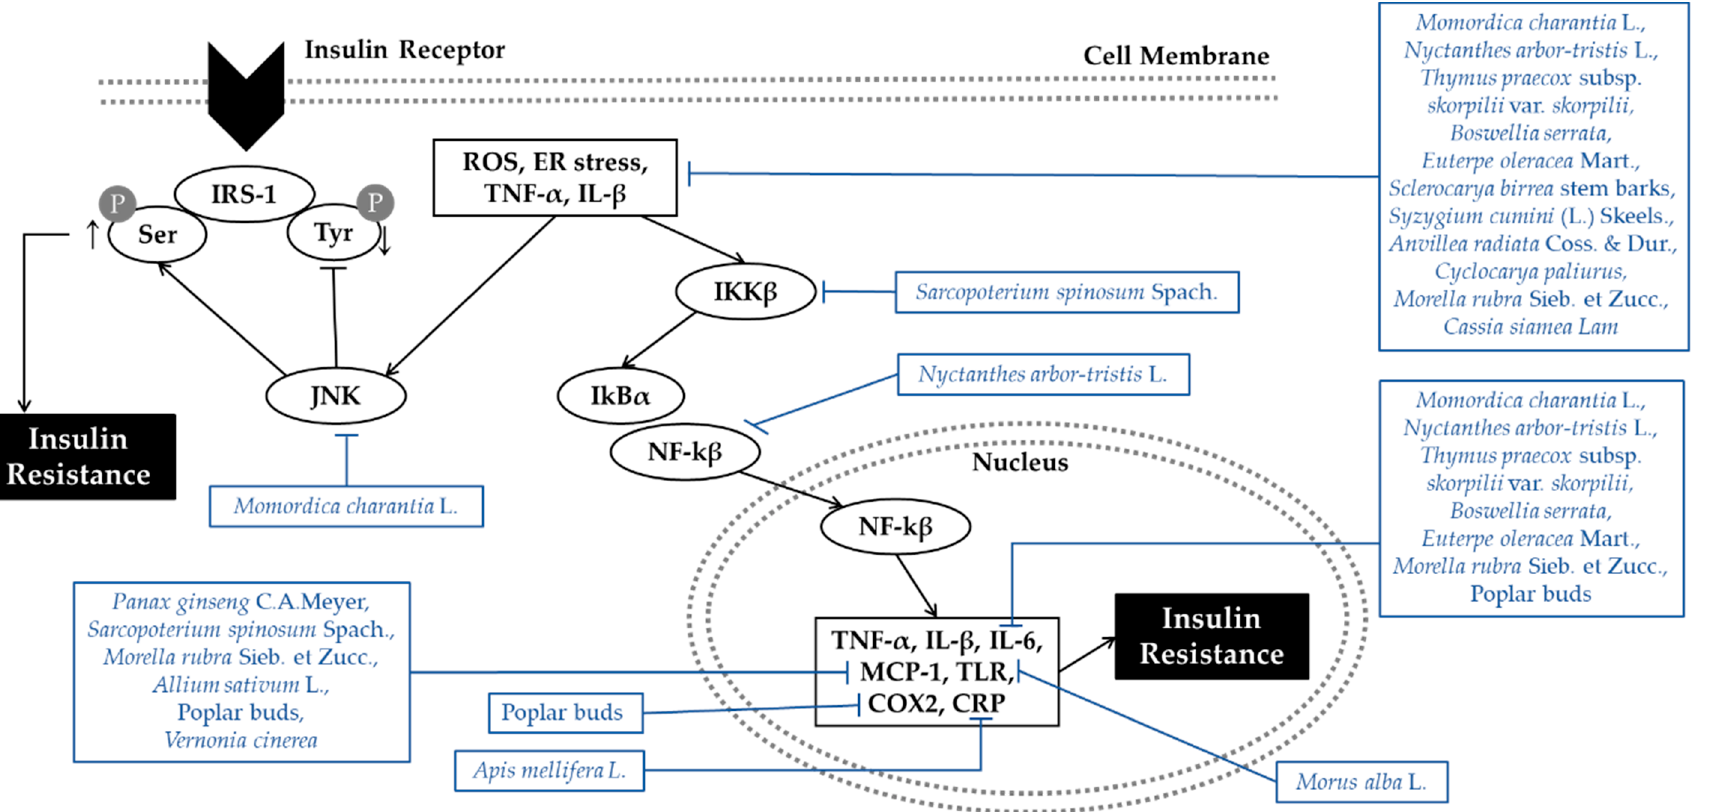
Figure 2. Schematic Diagram of Inflammation and Oxidative Stress. Inflammation and oxidative stress activate the JNK pathway and the IKK β /NF- κ B pathway, which leads to the increase in insulin resistance. In the nucleus, the elevation of pro-inflammatory cytokines and chemokines also promotes insulin resistance. Various plant extracts inhibited the activation of inflammatory mediators and antioxidant enzymes, which resulted in antidiabetic effects. (IRS-1, Insulin receptor substrate 1; JNK, c-Jun amino terminal kinase; IKK β , I κ B kinase- β ; NF- κ B, Nuclear factor kappa B; ROS, Reactive oxygen species; ER stress, Endoplasmic reticulum stress; TNF- α , Tumor necrosis factor- α ; IL-1 β , Interleukin-1 β ; IL-6, Interleukin-6; MCP-1, Monocyte chemotactic protein 1; TLR, toll-like Receptor; CRP, C-reactive protein; COX-2, Cyclooxygenase-2; Ser, serine; Tyr, Tyrosine.)